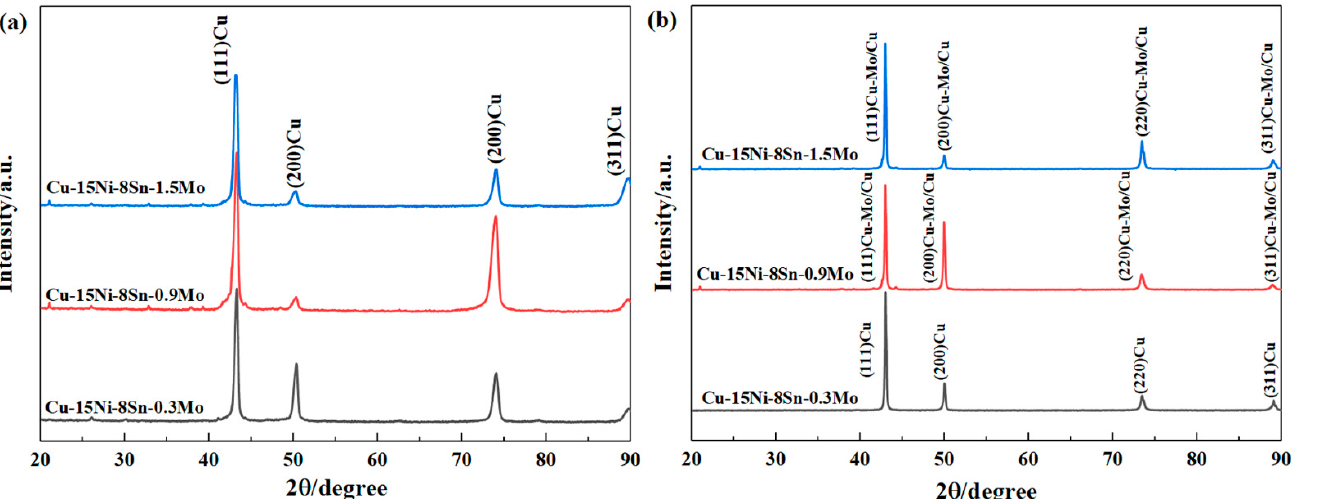
Figure 10. Metallographic microstructure of Cu–15Ni–8Sn–xMo (x = 0.3, 0.9, 1.5 wt.%) alloys aged at 400 °C for 1–8h: ( a 1 – e 1 ) x = 0.3, ( a 2 – e 2 ) x = 0.9, ( a 3 – e 3 ) x = 1.5 wt.%.